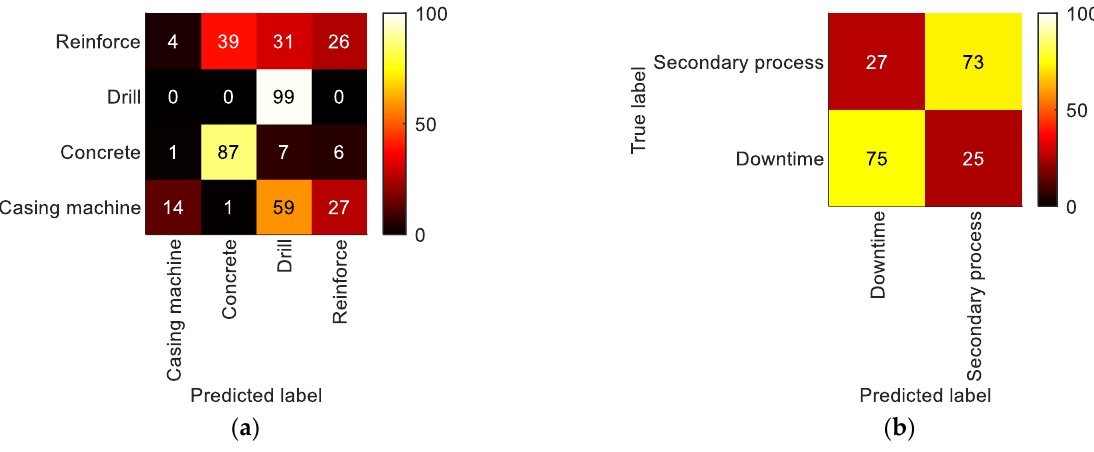
Figure A5. LoD2 confusion matrix for the DeepConvLSTM: ( a ) work; ( b ) idle.